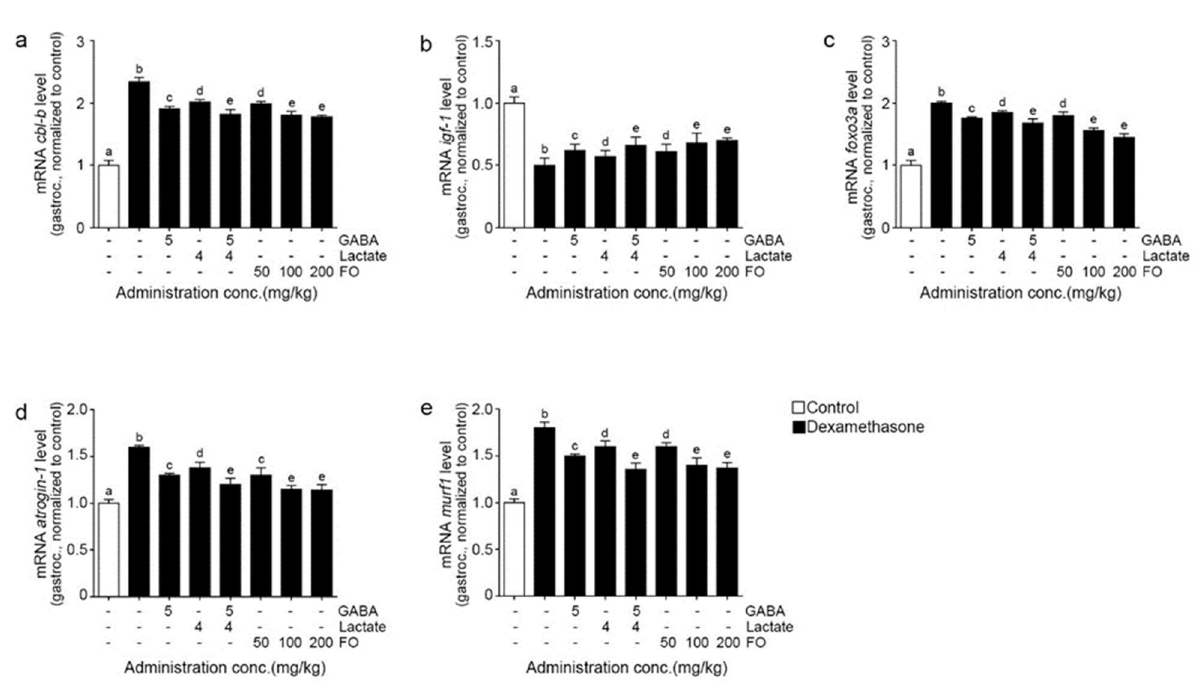
Figure 3. FO reduced muscle proteolysis through IGF-1 in a muscle atrophy-induced mouse model. ( a ) The mRNA levels of cbl-b were increased by Dexa/Saline but decreased by GABA, lactate, GABA+lactate, and FO treatment; ( b ) The mRNA levels of igf-1 were decreased by Dexa/Saline but increased by GABA, lactate, GABA+lactate, and FO treatment; ( c – e ) The mRNA levels foxo3a ( c ), atrogin-1 ( d ), and murf1 ( e ), were increased by Dexa/Saline but decreased by GABA, lactate, GABA+lactate, and FO treatment. a–e Different letters indicate significant differences among groups as determined by multiple comparisons (Mann-Whitney U test); p < 0.05. a muscle-specific F-box protein (atrogin-1); Cbl Proto-Oncogene B (cbl-b); fermented oyster extracts (FO); γ-aminobutyric acid (GABA); gastrocnemius (gastroc); forkhead box O3 (foxO3a); insulin-like growth factor 1 (igf-1); Muscle RING-finger protein-1 (murf1).